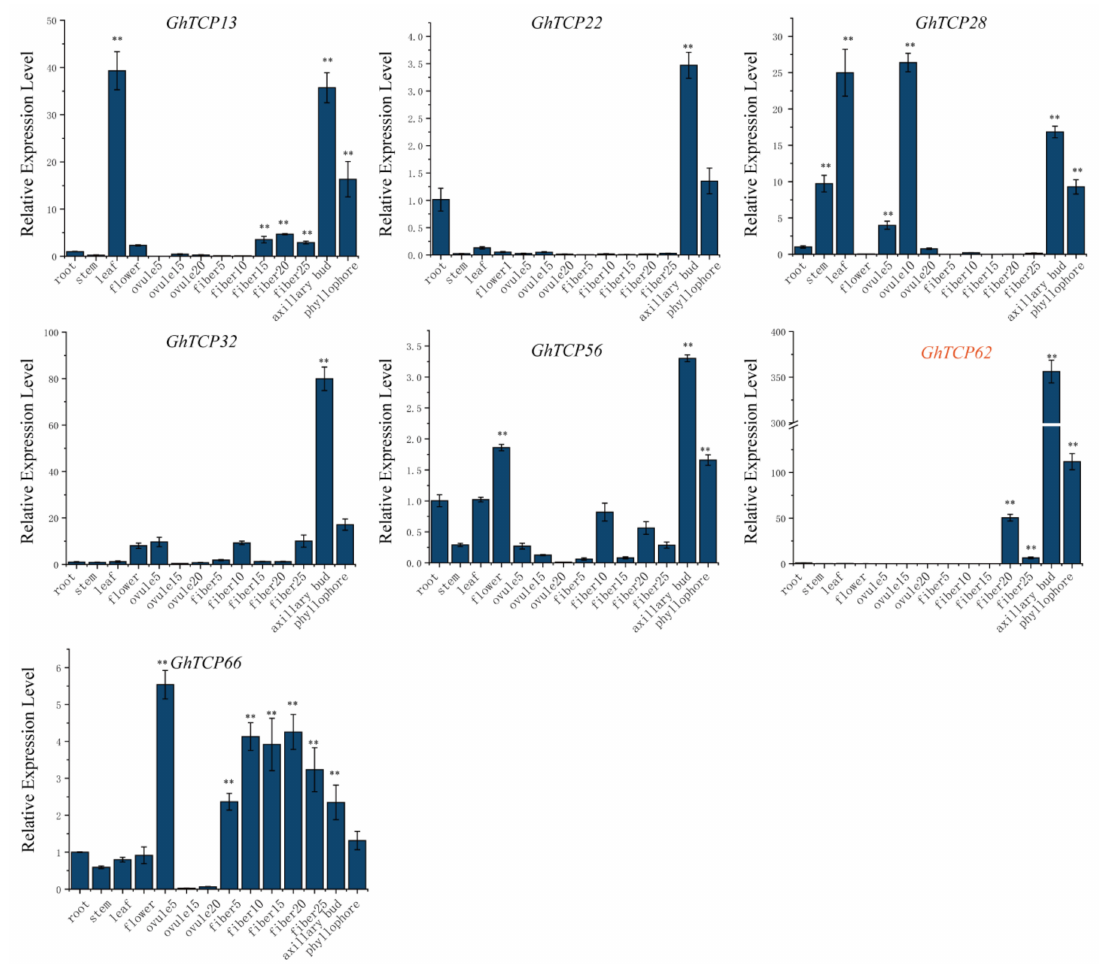
Figure 6. Analysis of tissue-specific gene expression patterns in cotton including root, stem, leaf, flower, fibers and ovules in different stage, axillary bud, and phyllophore. The y-axis represents the expression level of GhTCP genes relative to the reference gene Gh UBQ7 . The error line represents the standard deviation of three repetitions. The asterisks indicated significant differences compared to root (** p < 0.01 by t